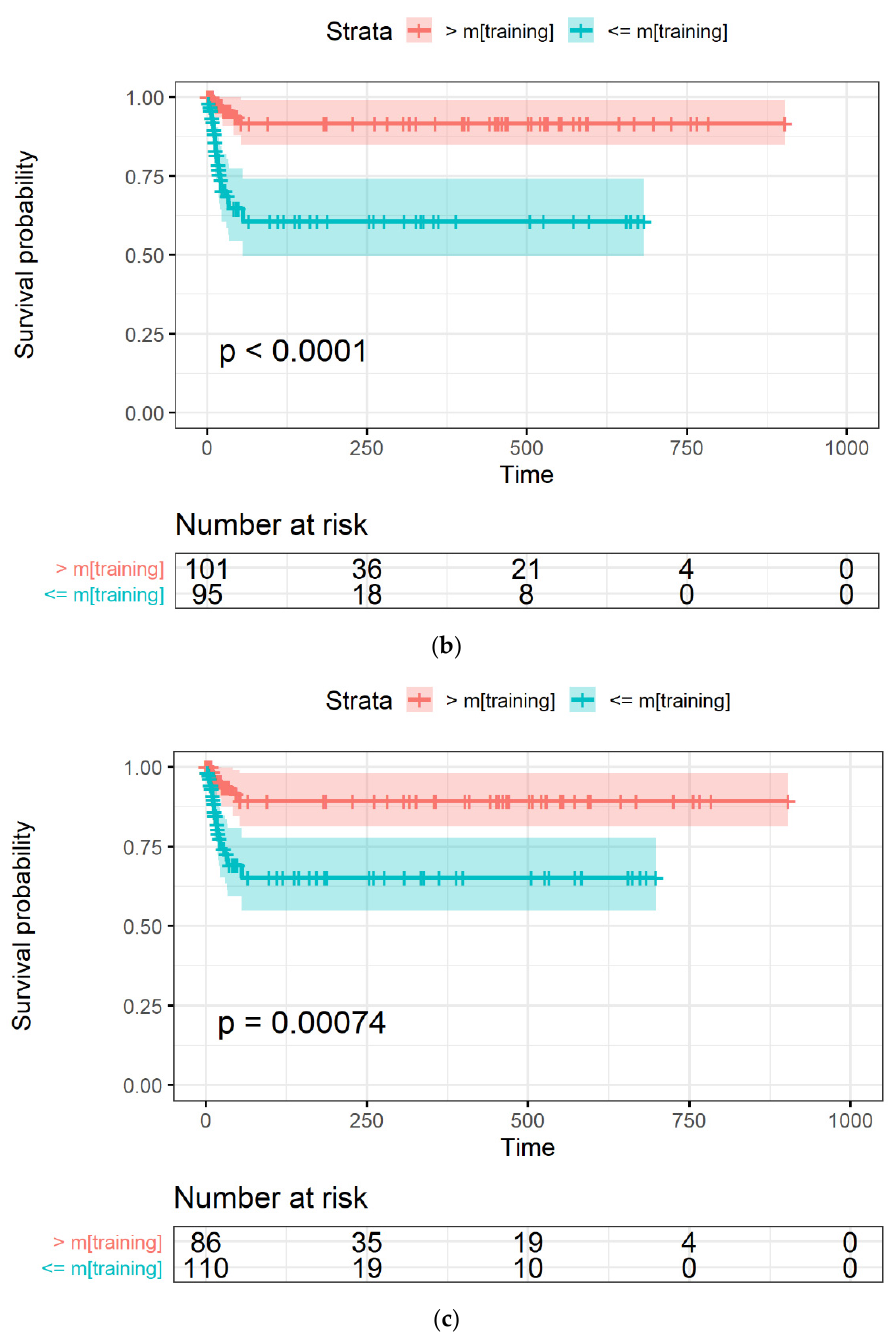
Figure 4. The Kaplan-Meier curves of OS versus time, expressed in days, in ( a ) training, and the two validation datasets, i.e., ( b ) Par-CT and ( c ) Med-CT. Patients are grouped using the LASSO-Cox-based score higher or lower that the median value calculated using the training dataset.